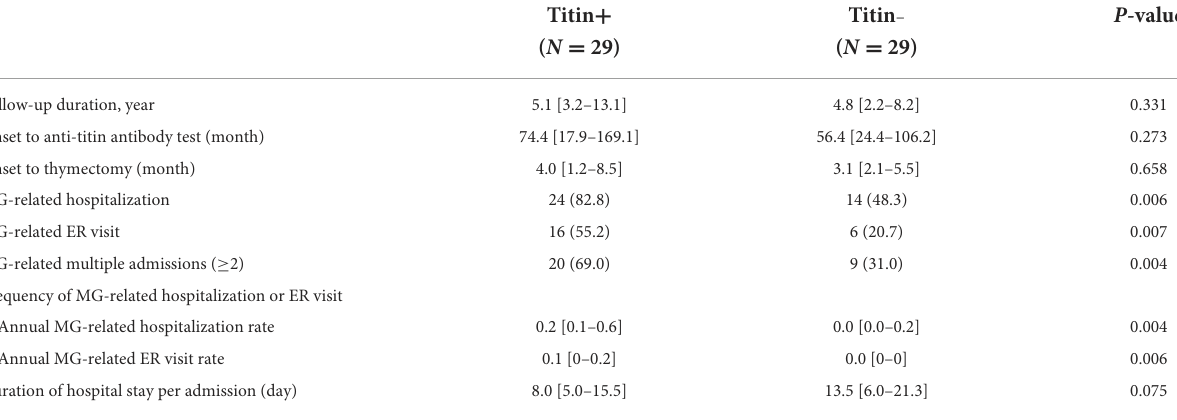
TABLE 2 Comparison of MG-related hospitalization and MG-related emergency room visit between the titin + and titin– groups among 58 patients * with follow-up duration of ≥ 1 year.